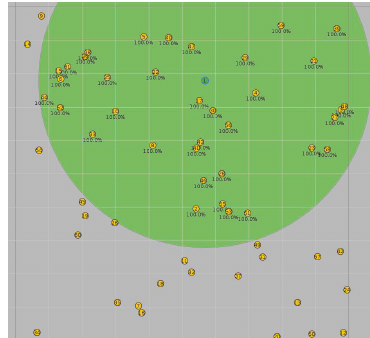
Figure 7: The number of broadcast rounds regarding the lifetime of first dead nodes and that of the network lifetime.